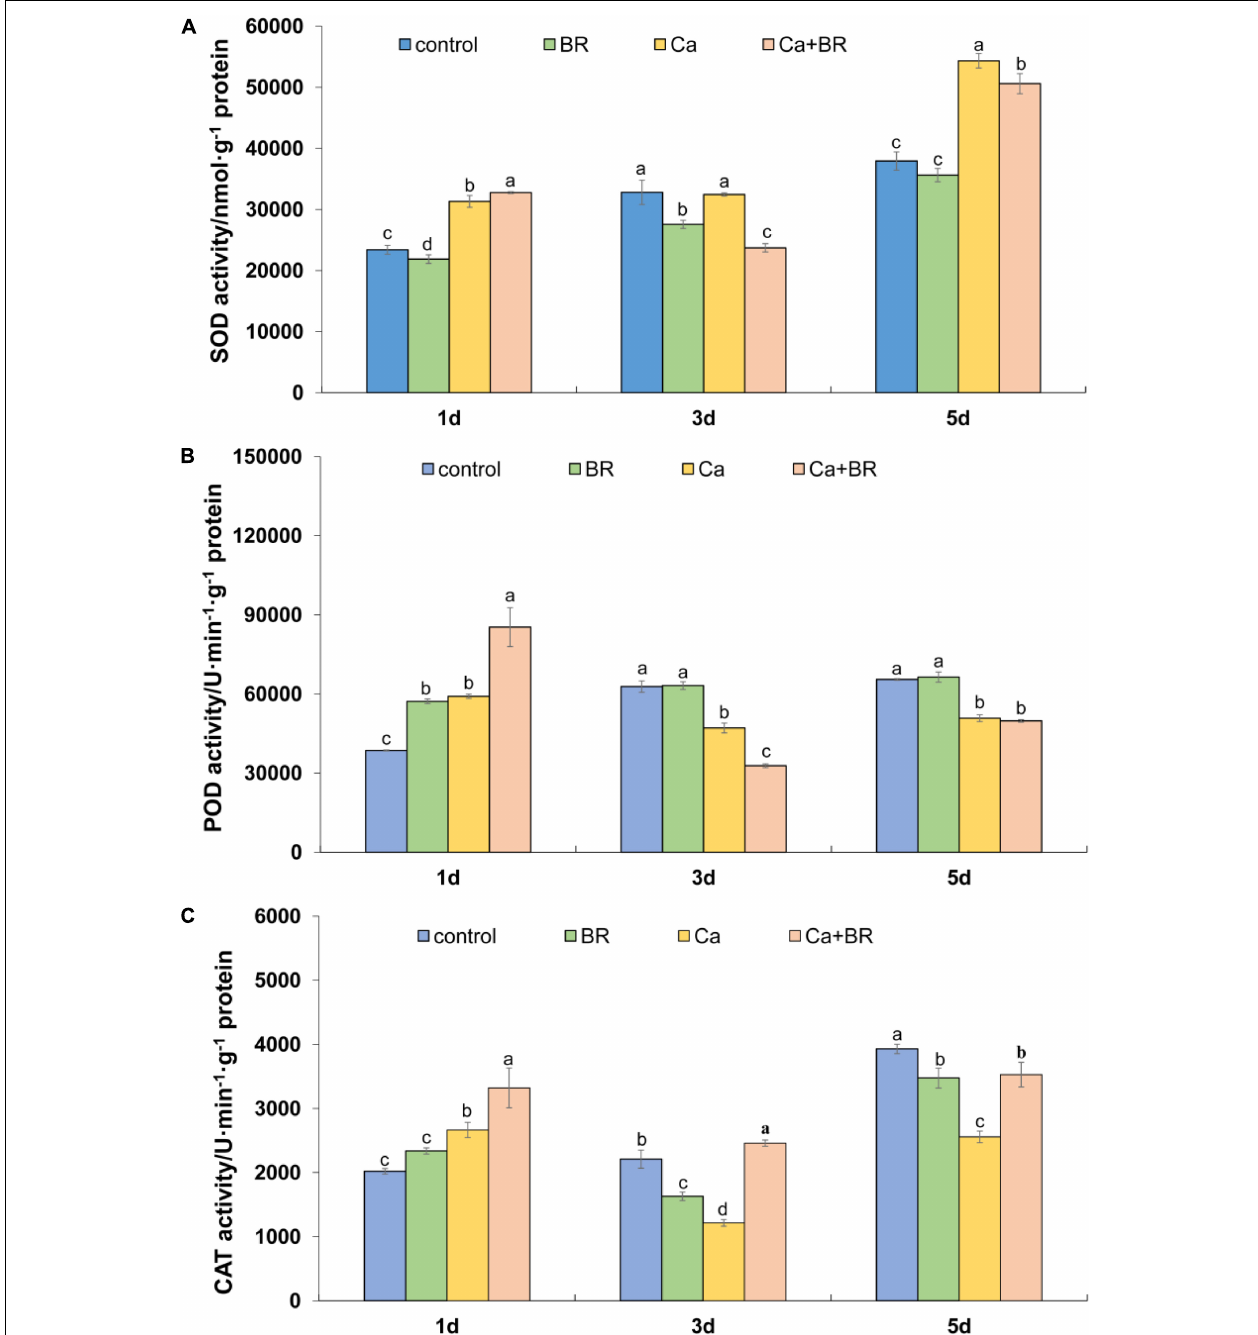
FIGURE 5 | Antioxidant enzyme activity in the leaves of the tomato seedling subjected to Ca(NO 3 ) 2 , foliar spraying with BR, or their combinations. (A) Superoxide dismutase (SOD) activity. (B) Peroxidase (POD) activity. (C) Catalase (CAT) activity. BR, 0.1 µ mol/L brassinolide; Ca, 100 mmol/L Ca(NO 3 ) 2 ; Ca+BR, 100 mmol/L Ca(NO 3 ) 2 stress plus foliar spraying with exogenous BR. Each data point represents the mean of three independent biological replicates (mean ± SD). Different letters above the bars indicate statistically significant differences ( P < 0.05).